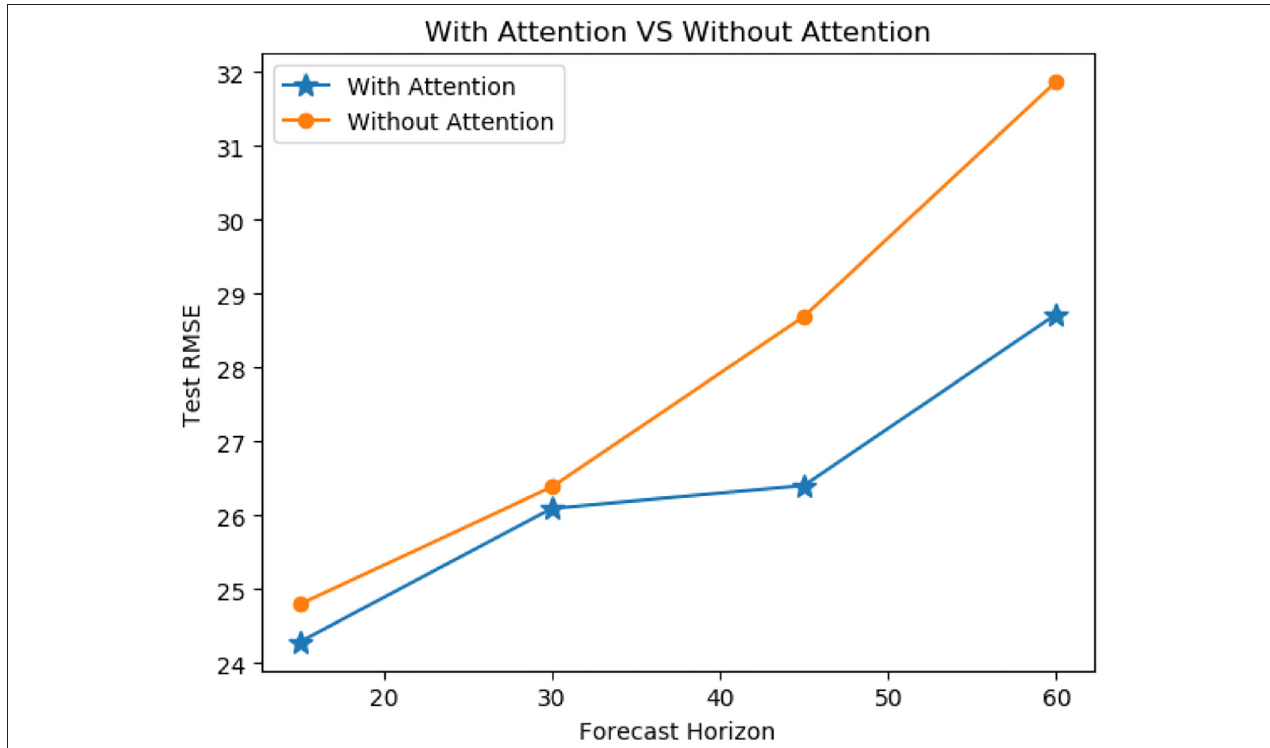
FIGURE 8 | Average performance comparison of models with or without attention mechanism on